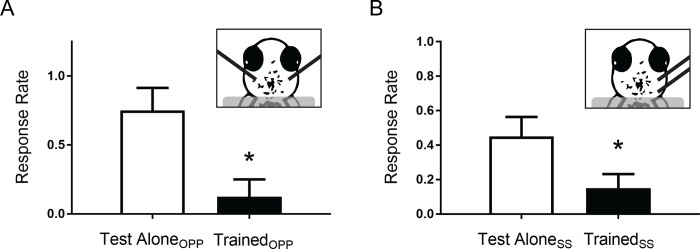
Rapid habituation of the touch-induced C-start reflex is circuit-specific.(a) Comparison of the response rate of restrained larvae given habituation training with electrical shocks to one side of the head (TrainedOPP, n = 8) to their response rate to test stimulation alone of the opposite side (OPP) of the head (Test AloneOPP, n = 8). A paired t-test determined that the responsiveness of the trained side was significantly less than that of the untrained side (t
[7] = 3.42; p < 0.05). Long black bars in this and the following figure (part [b]) represent the tips of the extracellular electrodes. (b) Comparison of the response rates of larvae to habituating stimulation (TrainedSS, n = 20) and to test stimulation alone delivered to the same side (SS) of the head (Test AloneSS, n = 20). The electrodes stimulated patches of skin whose sensory afferents synapsed onto the same M-cell. A paired t-test indicated that the response rates to the posttest stimuli differed significantly (t
[19] = 2.35; p < 0.05).